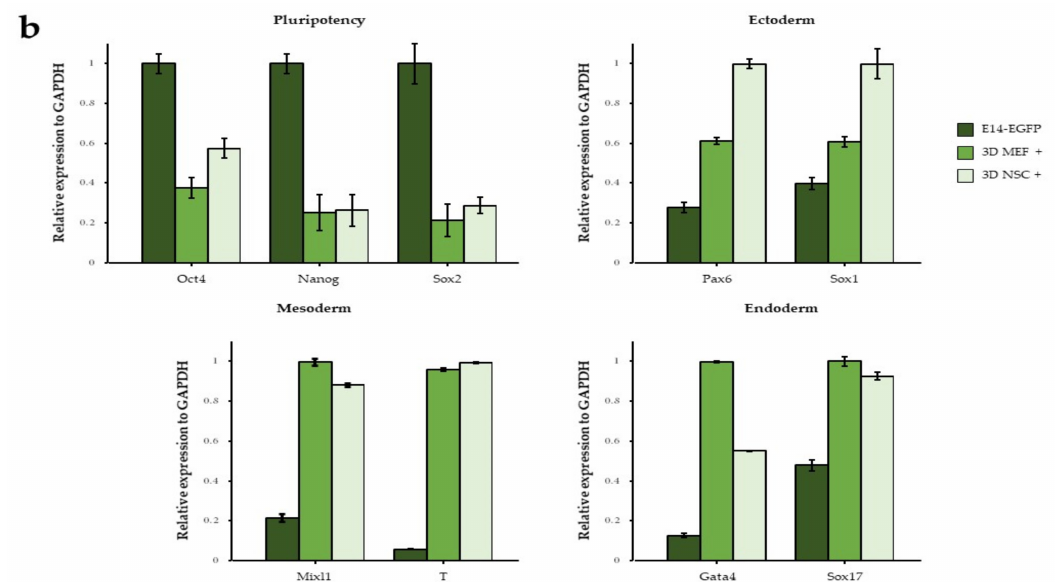
Figure 5. E14-EGFP co-cultured with NSC/MEF under 2D or 3D conditions express three embryonic germ markers. Pluripotency, ectoderm, mesoderm, and endoderm markers of E14-EGFPs 2D co- cultured with NSC or MEF feeder in FBS medium for 3 days ( a ) or 3D co-cultured with NSC or MEF in FBS medium for 6 days ( b ). EGFP-expressing cells were purified by FACS sorting. Data are mean ± SE, n = 3 biological